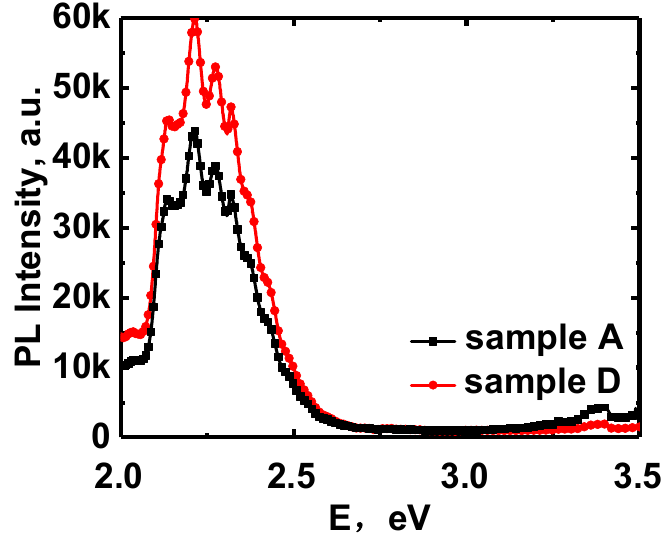
Figure 5. Photoluminescence (PL) spectra of sample A and sample D.